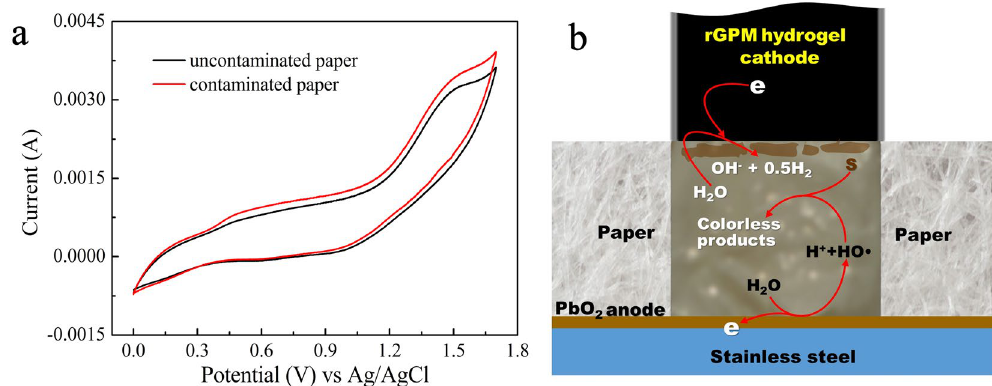
Figure 7. The typical cyclic voltammograms of HPEC process ( a ) and a proposed mechanism of the elimination of stains during HPEC process ( b ). A the safranine T undyed and dyed paper were respectively inserted between rGPM 5.0 cathode and the PbO 2 anode, and the scan rate was 50